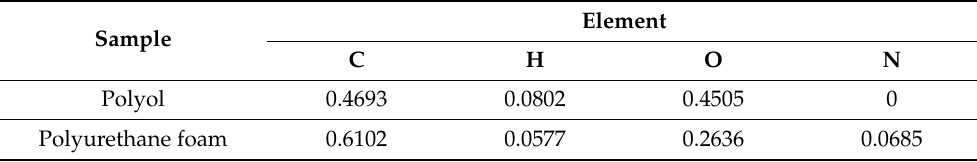
Table 10. Mass shares of individual elements in polyol (CS + GL + EC) and the obtained polyurethane foam. Element Sample C H O N Polyol 0.4693 0.0802 0.4505 0 Polyurethane foam 0.6102 0.0577 0.2636 0.0685 BOD soil = 8.5 mg/dm 3 .